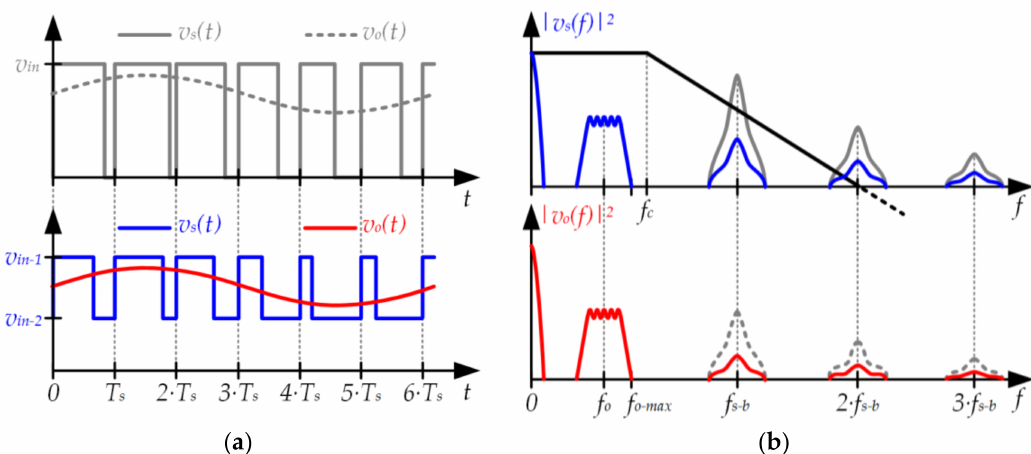
Figure 10. ( a ) Pulse-width modulator using a pulse voltage waveform that alternates between two positive voltage values ( v in − 1 and v in − 2 ); ( b ) Reduction of the switching-related harmonics at the filter input and, as a consequence, at the filter output.